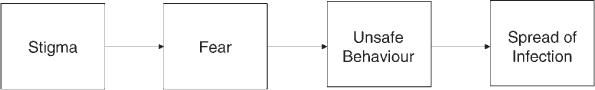
The Argument for the Link between the Stigma of HIV and the Global HIV Epidemic